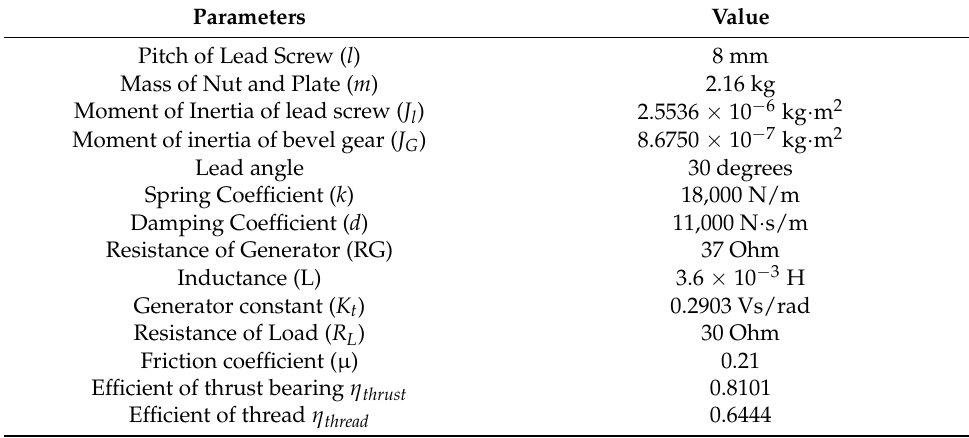
Table 1. Genpath V2